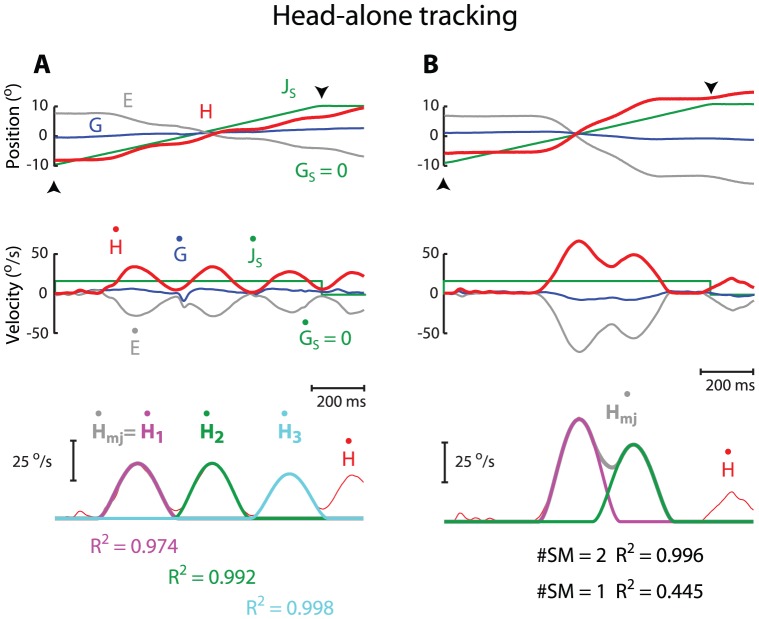
Two examples of submovement composition during head-alone tracking.Top two rows depict position (top) and velocity (middle) traces, respectively, separated for gaze movement (G; blue), head movement (H; red), eye movement (E, re head; gray), and juice spout motion (Js; green). Bottom panels depict the profiles of the head velocity (H, thin red) and the minimum-jerk model of head velocity (Hmj, thick gray). Task-associated head movement was selected between the onset (▴) and offset (▾) of juice spout motion. The order of the submovements is coded in color (first: magenta; second: green; third: light blue). Time scale is identical across all plots. To facilitate data comparison, the head movements are plotted in positive directions regardless of whether the movements were rightward or leftward, the other movements were rectified accordingly. Note the goodness of fit in B improved by 55.1% from a single submovement model (#SM = 1; 55.5% error) to two overlapping submovement model (#SM = 2; 0.4% error).